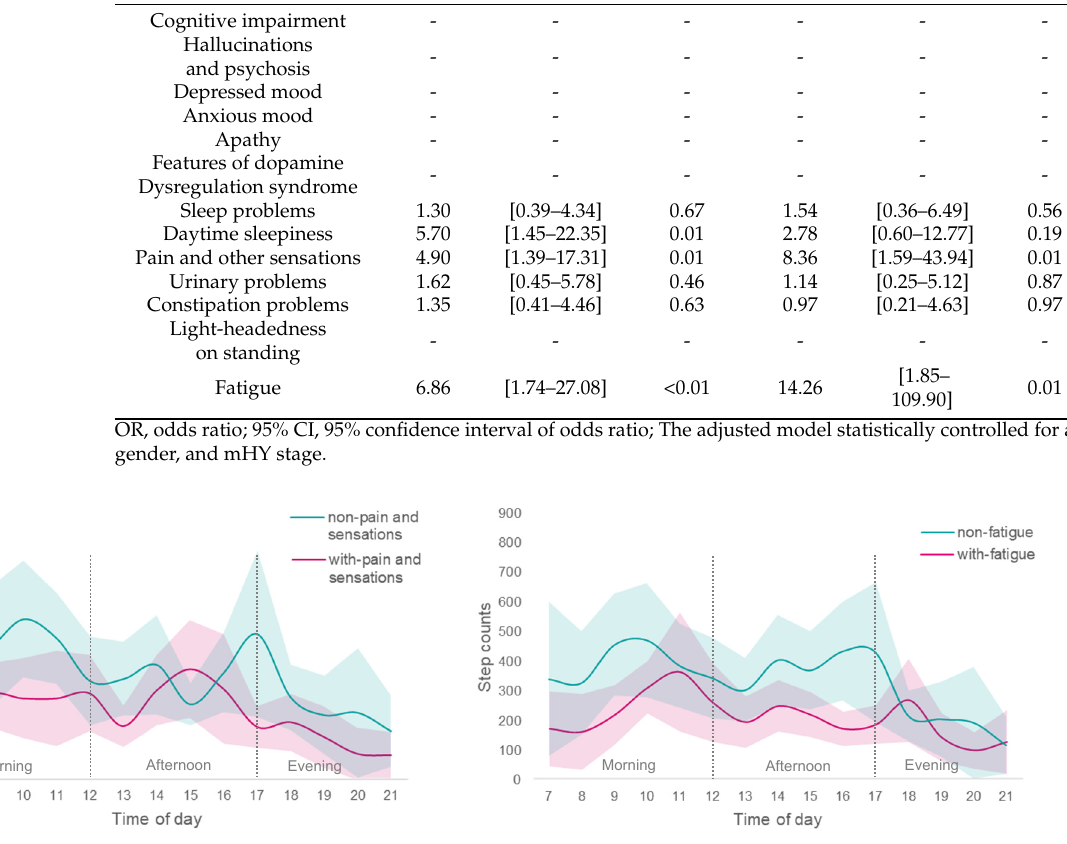
Table 2. Association between low step counts and non-motor symptoms by logistic regression analysis [dependent variable: low step count (<4200 steps/day)].